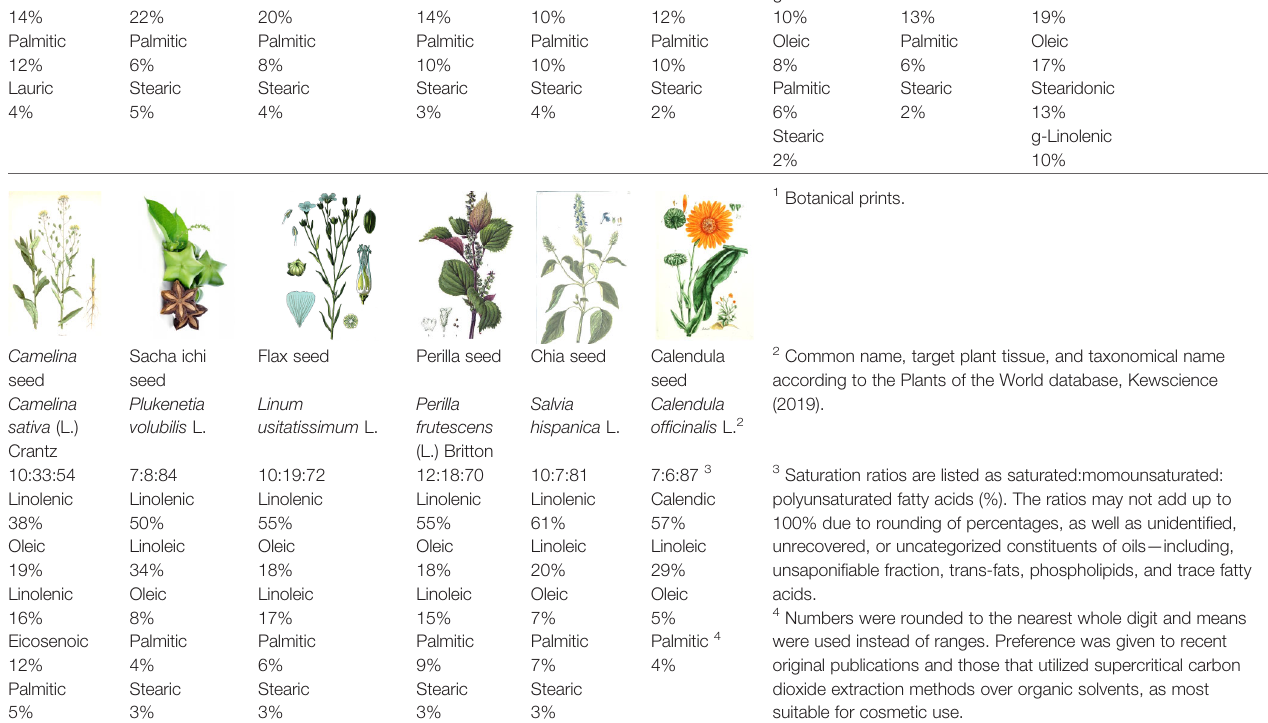
Carthamus tinctorius L.